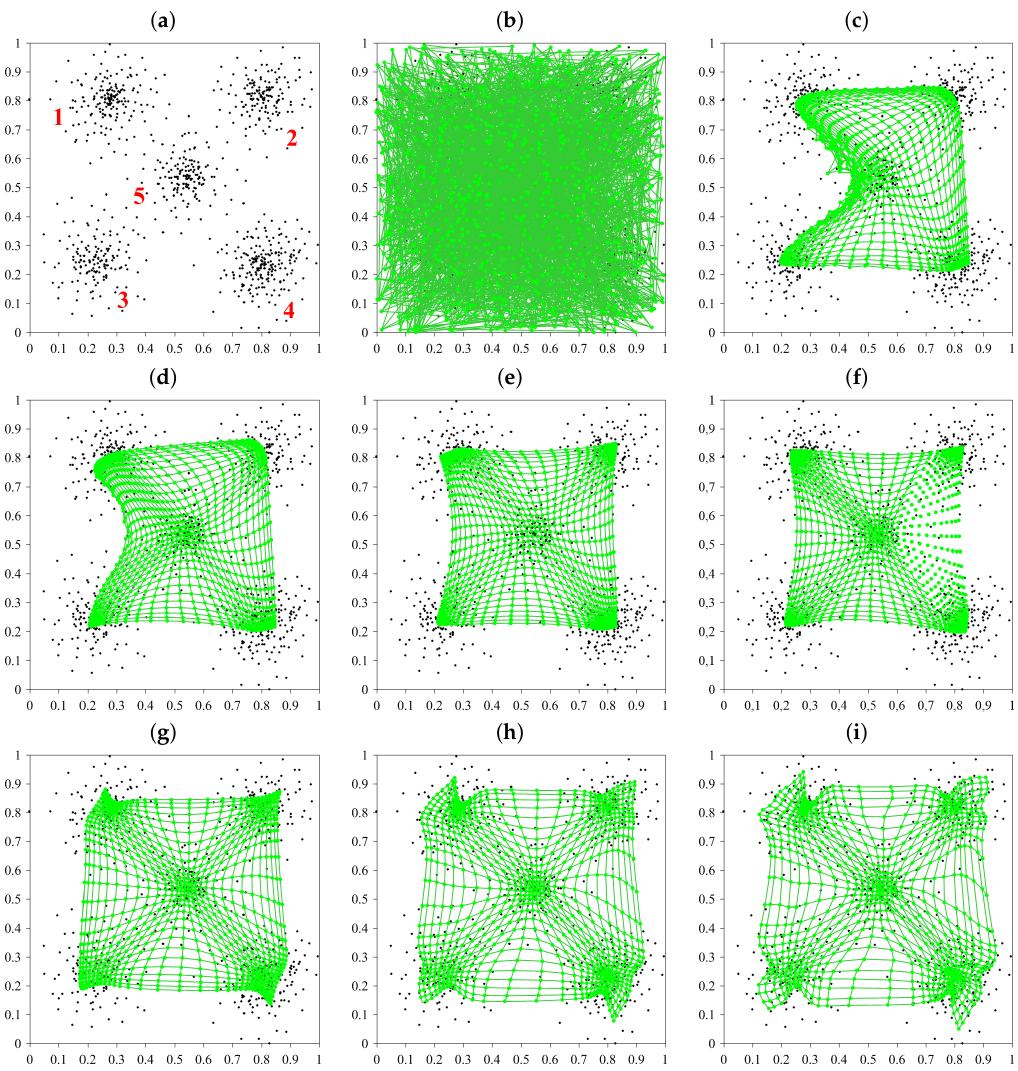
Figure 5. Synthetic data set ( a ) and the evolution of the conventional SOM in it in learning epochs: ( b ) No. 0 (start of learning), ( c ) No. 1, ( d ) No. 2, ( e ) No. 3, ( f ) No. 5, ( g ) No. 500, ( h ) No. 800, and ( i ) No. 1000 (end of